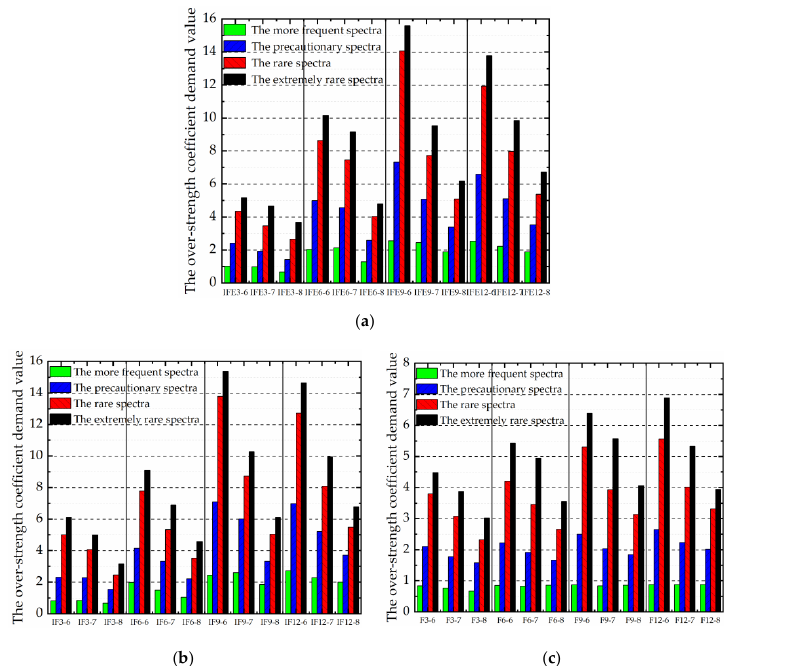
Figure 11. Demand analysis based on dynamic capacity spectra: ( a ) bare frame; ( b ) gully infilled frame; ( c ) bottom soft-story infilled frame.